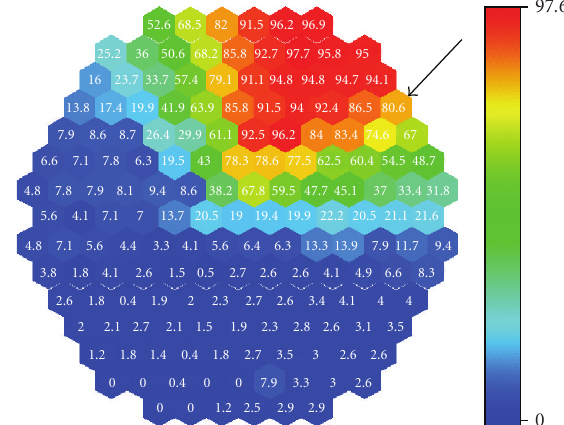
Figure 2: Estimated and interpolated relative core inlet tempera- tures rise [%].